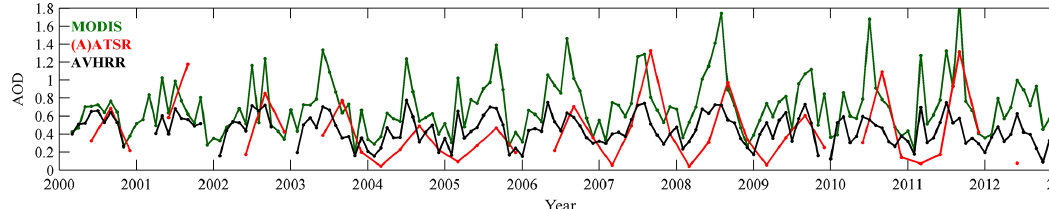
Figure 11. As in Fig. 10 but over the XiangHe